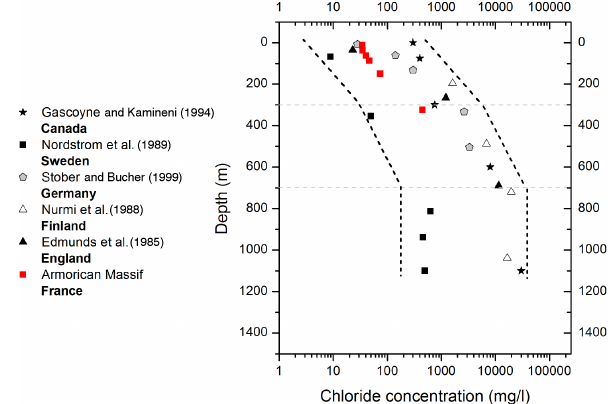
Figure 8. Chloride concentration (mgL − 1 ) versus depth (m) recorded in continental basements around the world compared with the data of the current